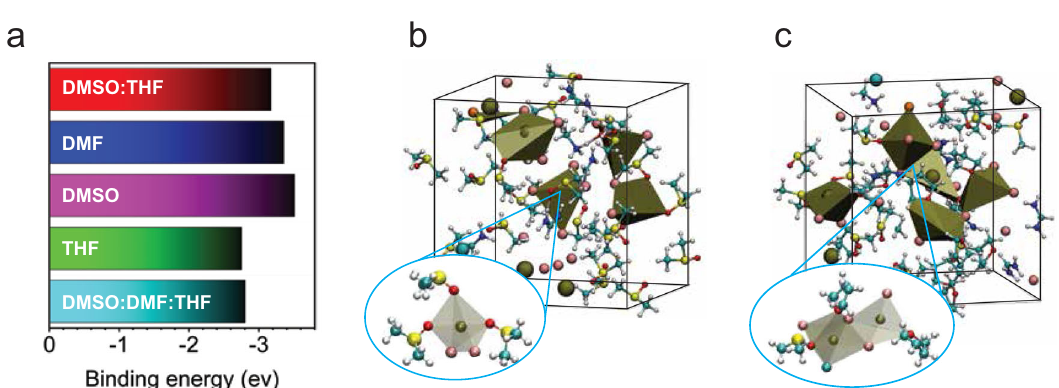
Fig. 3 Solvent-solute interactions. a Average binding energies of Pb 2 + ions with solvents and their mixtures (evaluated on the tetracoordinated complexes shown in Supplementary Fig. 9). b , c Ab initio MD simulations of perovskites precursors in b DMSO and c THF/DMSO mixture after ~15 ps. All species are shown with balls and sticks representations. Pb ions are shown with golden color, I with pink color, Cs with greenish-blue, Br with orange, C with light blue, N with dark blue, O with red, S with yellow and H atoms with white color. In the b and c panels, lead coordination polyhedra are shown within a 3.6 Å